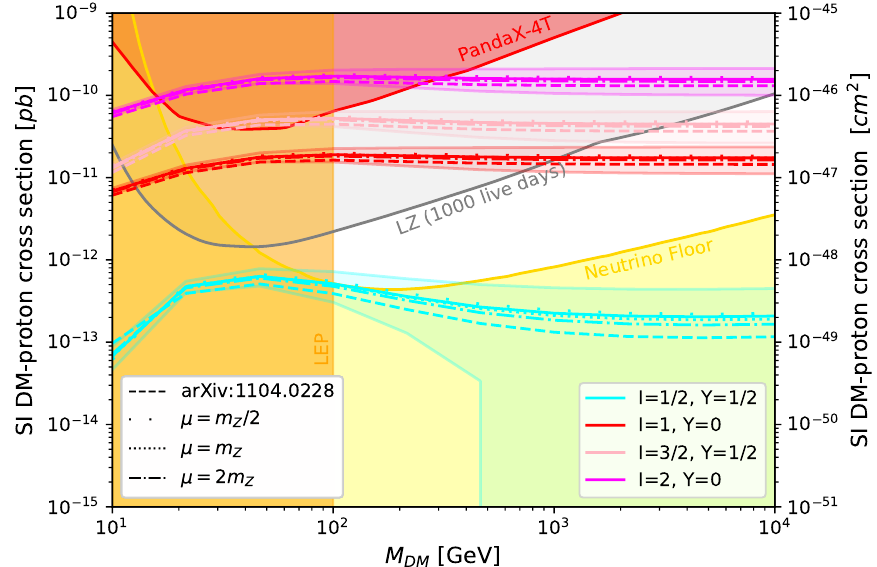
Figure 7. Impact of form factor and PDF uncertainties on the SI cross section for various models with a single DM fermion multiplet. We show results for pseudo-Dirac cases. For Y = 0 , Majorana and Dirac cases can be obtained by a simple scaling of the cross sections by a factor of 1 / 4 and 4 respectively. We recall that only the pseudo-Dirac case is allowed for Y 6 = 0 . Note that the cancellation at low masses, around 10 GeV, does not appear here because of the sampling used to construct the curve. We do not investigate it further as it lays within an excluded